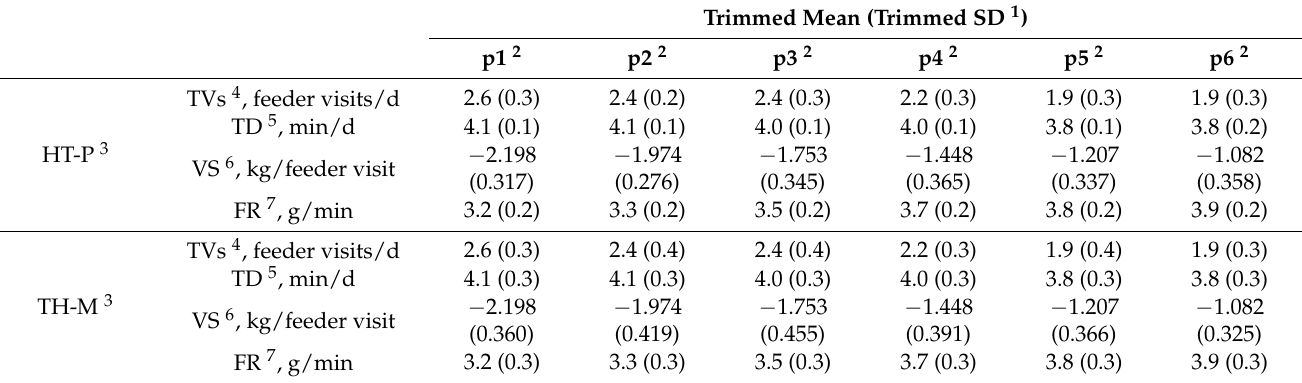
Table 3. Trimmed mean and trimmed standard deviation of the feeding behaviour habits by trial and period. Standardized z -scores are obtained from these descriptive